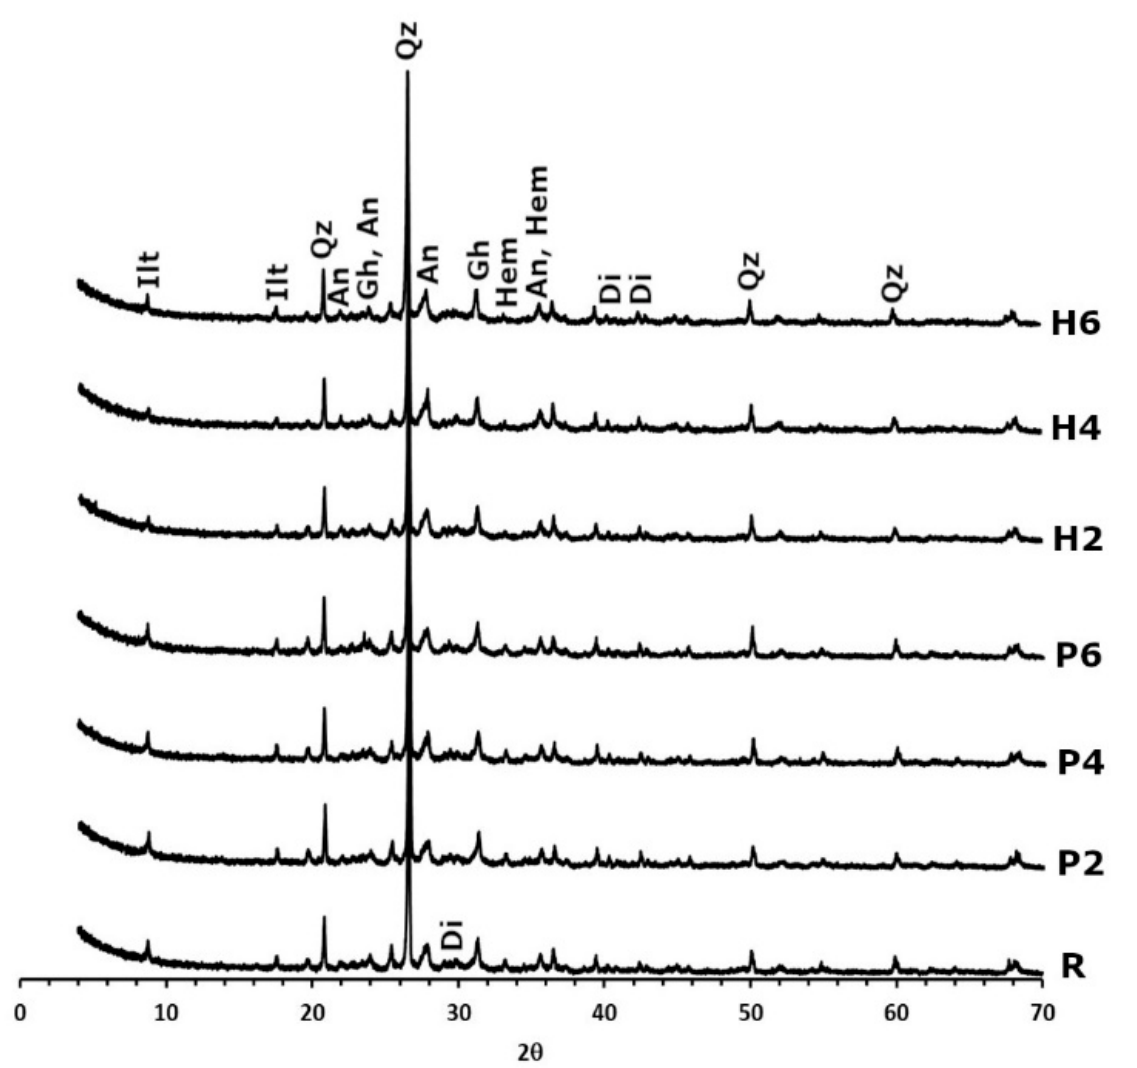
Figure 3. X-ray diffraction patterns of fired bricks without waste (R), with EPS (P2, P4 and P6) and with olive stones (H2, H4, and H6). Ilt: illite; qz: quartz; an: anorthite; gh: gehlenite; hem: hematite; di: diopside. Abbreviations suggested by Warr [40].